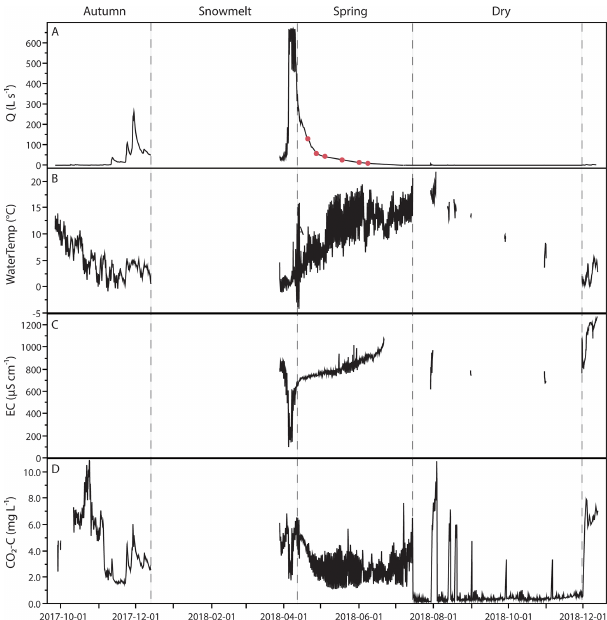
Figure 3. Time series of (a) stream discharge ( Q ) with sampling days for δ 13 C-DIC highlighted by red dots, (b) stream water tem- perature, (c) electrical conductivity (EC), and (d) CO 2 concentra- tion for the study period 26 September 2017–12 December 2018, with a break for the ice- and snow-covered period December– March. The CO 2 data include periods when the sensor was above the water surface during dry periods in summer and autumn of